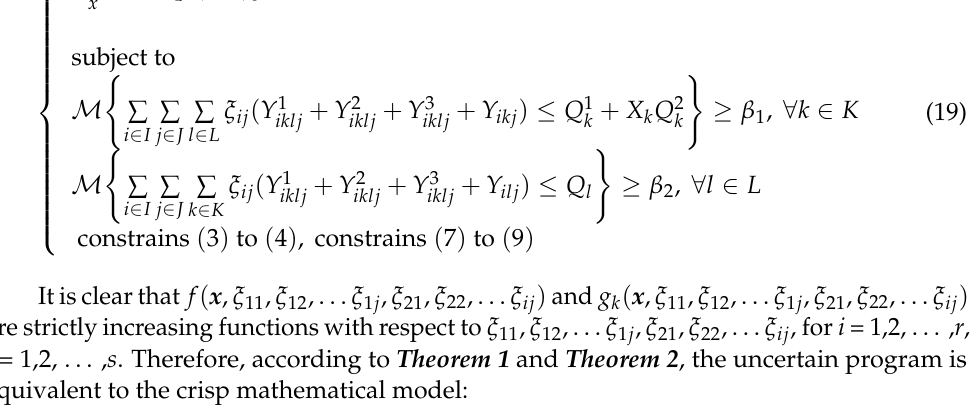
Figure 3. Zigzag uncertainty